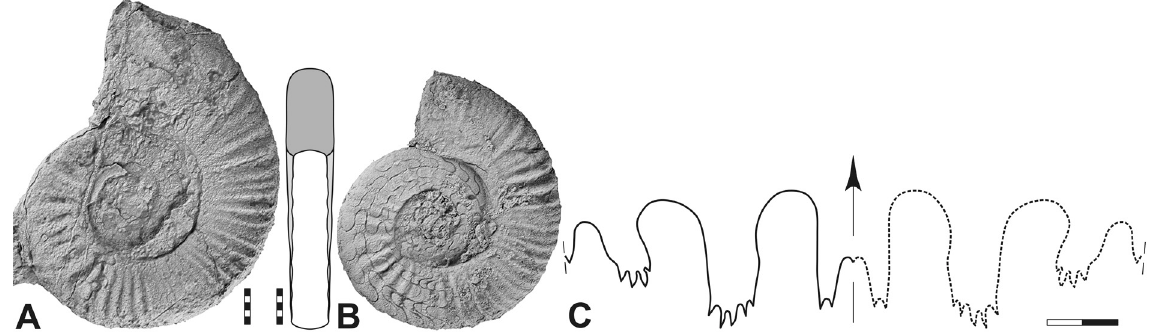
Fig. 19. Shevyrevites corrugatus Korn & Hairapetian sp. nov. A . Lateral and dorsal view, paratype MB.C.29719, section A, float. B . Lateral and dorsal view, holotype MB.C.29718, section A, float. C . Suture line, holotype MB.C.29718, at 9.4 mm wh. Abbreviation: see Material and methods. Scale bar units = 1